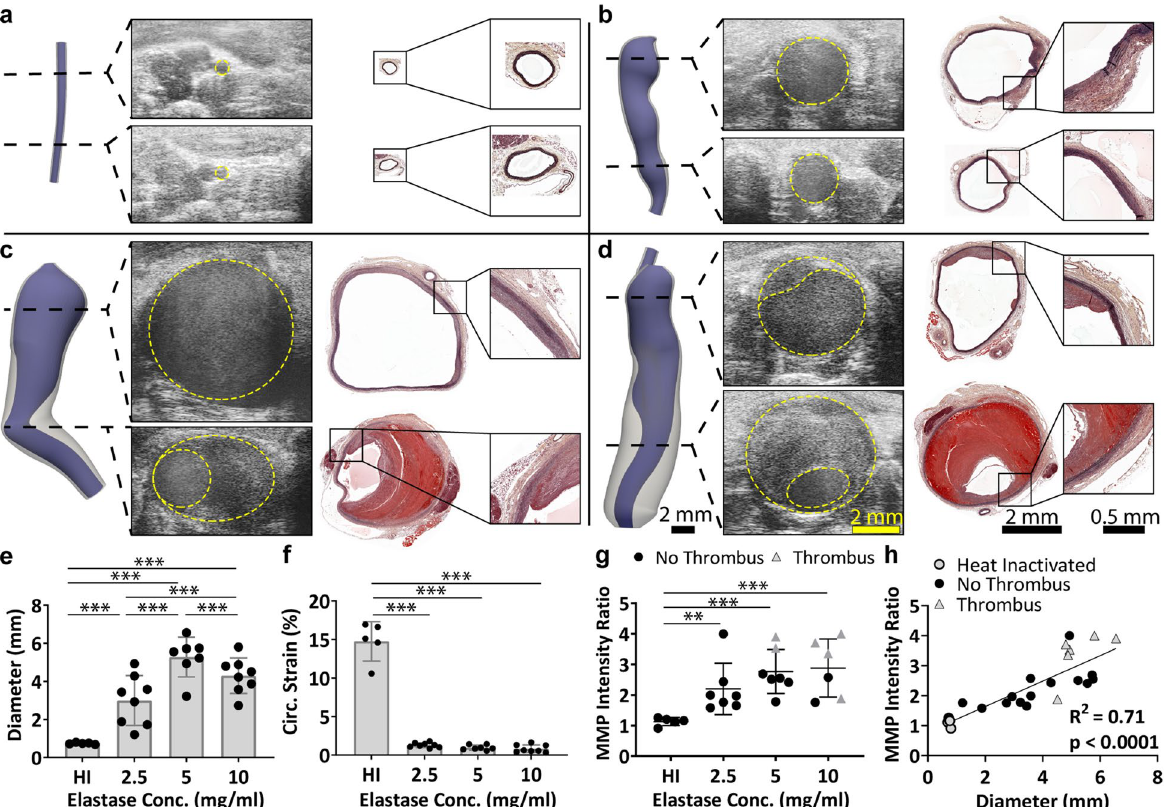
Figure 3. Chronic effects in mice treated with varied elastase concentrations. Ultrasound-based 3D segmentations at day 56 compare well with end-of-study histology (MPC shown). ( a ) In mice treated with heat- inactivated elastase, the aortas showed no degradation of the elastin and remained the same size throughout the study. In contrast, mice treated with ( b ) 2.5 mg/ml, ( c ) 5 mg/ml, and ( d ) 10 mg/ml elastase-treated groups had fragmented elastin and varying-sized aneurysms. In addition, although not all mice in the 5 and 10 mg/ ml groups had thrombus, those that did have thrombus tended to have a thin proximal wall and a thrombus- laden distal portion. ( e ) Diameter measurements indicated a graded effect of elastase concentration, with the 2.5 mg/ml group having moderately-sized aneurysms, and the 5 and 10 mg/ml groups having large aneurysms. ( f ) Despite differences in diameter, circumferential strain was statistically indistinguishable among elastase- treated groups, and was only different from the heat-inactivated control. ( g ) MMP activity was also increased in aneurysmal mice, which correlated linearly with diameter ( h ). Of interest, mice with thrombus tended to have higher MMP activity (not statistically assessed). * p < 0.05; ** p < 0.01; *** p < 0.001 with lines indicating the